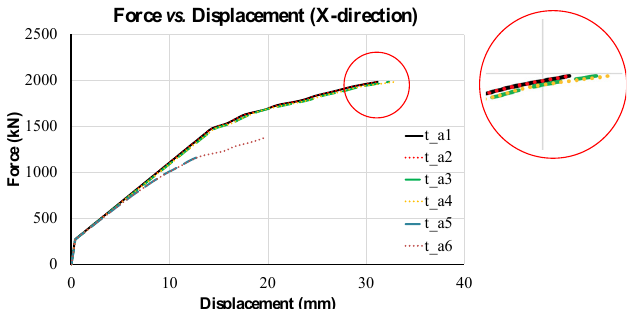
Figure 15 . Force vs. displacement influence of friction angle on the concrete ‐ concrete contact condition.